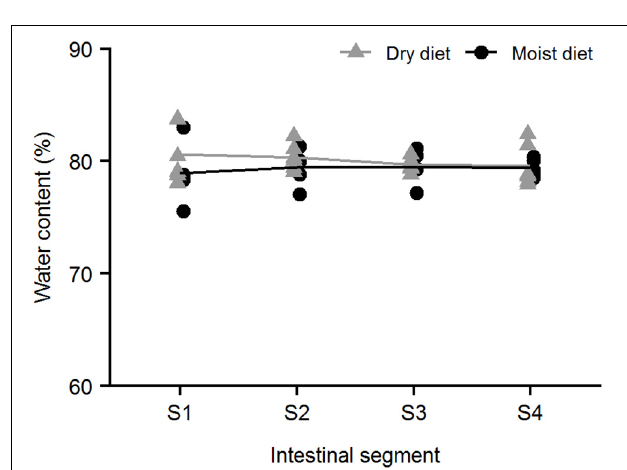
FIGURE 5 | Water content of digesta in ballan wrasse intestine. The water content of digesta from the four intestinal segments (S1–S4) of fish that were fed either moist or dry diets ( n = 6 for each segment each